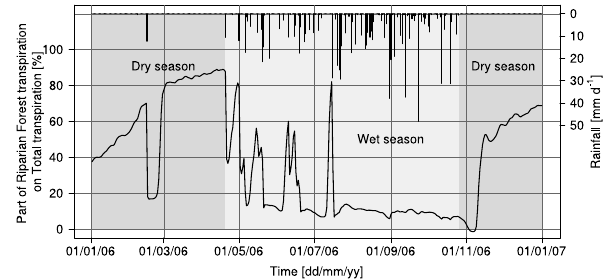
Fig. 10. Part of the riparian forest transpiration on total transpiration (%) for year 2006. This variable is built by subtracting the transpi- ration of simulation 3 from the transpiration of the 2006 simulation and then dividing this difference by the transpiration of the 2006 simulation. Rainfall is plotted on the top, scale being on the right- hand side. Shaded areas show the dry season (dark grey) and the wet season (light